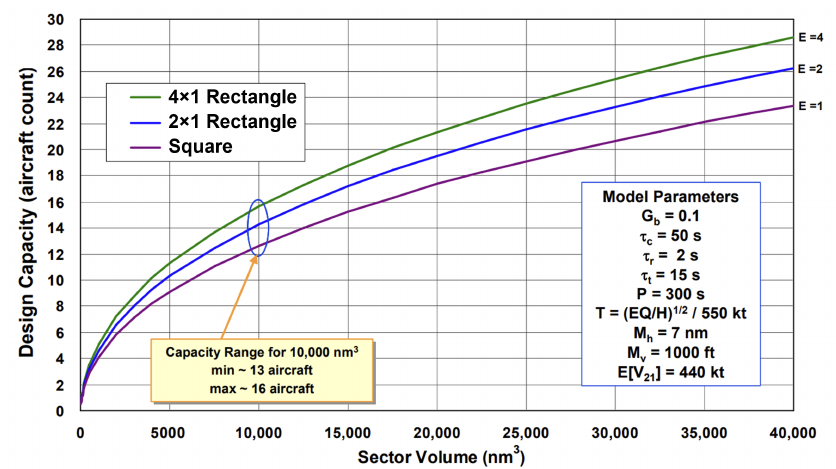
Figure 6. Aircraft capacity estimation against sector volume for a range of airspace scenarios. E refers to the length-to-width ratio of the sector, G b , τ C , τ r and τ r are all empirical parameters related to controller workload, P is the mean task recurrence period per aircraft, T is the sector transit time, M h and M v are the designated horizontal and vertical separation minima between aircraft within the sector and E[V 21 ] is the typical aircraft closing speed [75]. Figure obtained from Welch et al.